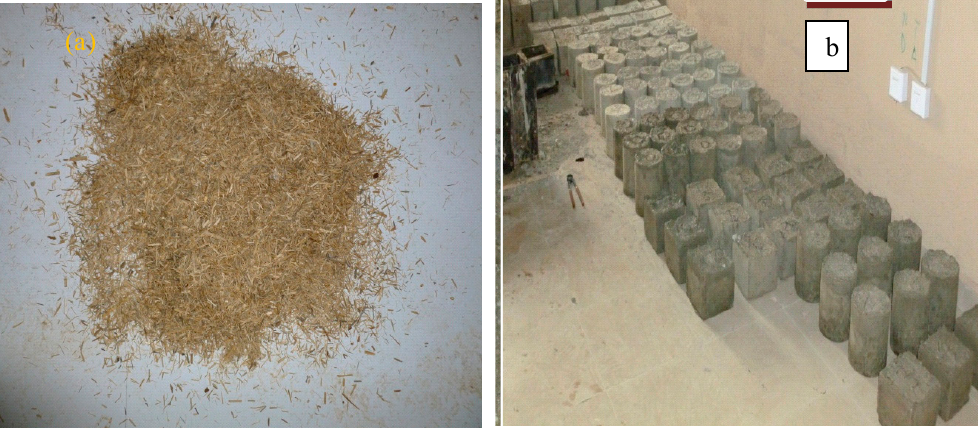
Figure 1. ( a ) Treated bamboo fibers from construction waste, ( b ) latex modified mortar samples.